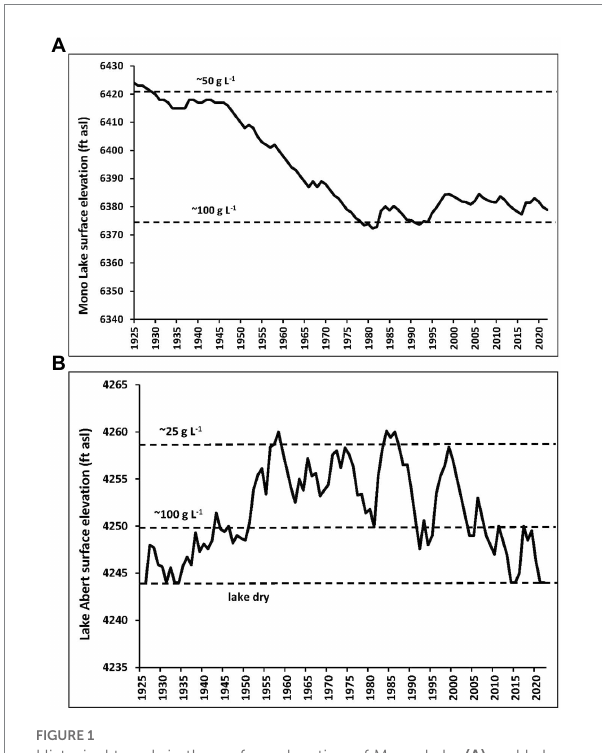
FIGURE 1 Historical trends in the surface elevation of Mono Lake (A) and Lake Abert (B) , showing key salinity levels associated with lake elevation (feet above sea level, asl). Mono Lake levels and salinity: https://www. monobasinresearch.org/data/levelyearly.php (Mono Basin Clearinghouse), and (Herbst, 1988). Lake Abert levels and salinity: (Larson et al.,